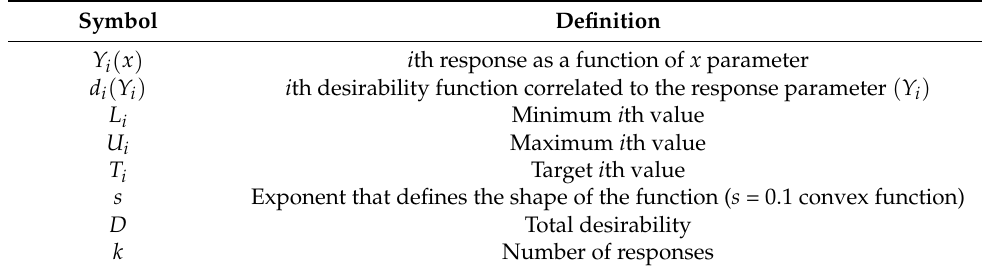
Table 2 presents the notation related to the equations. Table 2. Notation for the definition of desirability functions. Table 2. Notation for the definition of desirability functions.